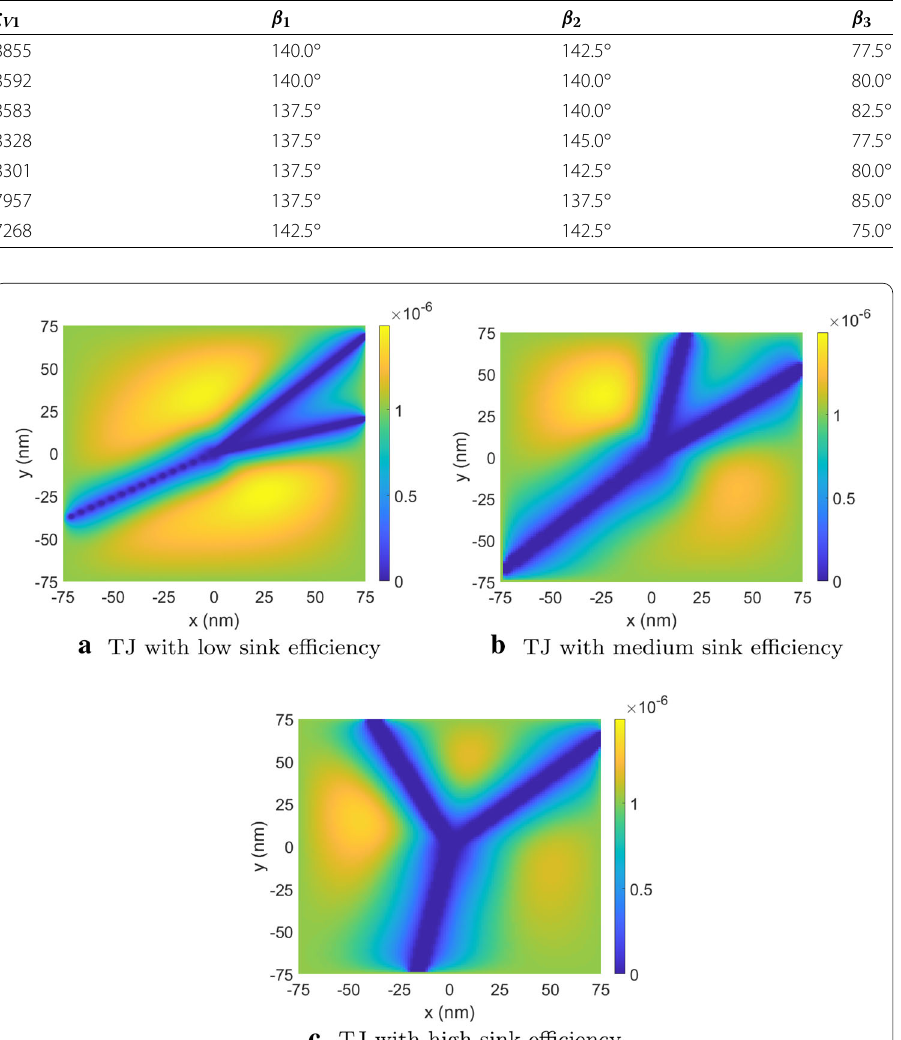
Table 3 Sink efficiency and dihedral angles for the TJ configurations with the 7 highest values of ζ V 1